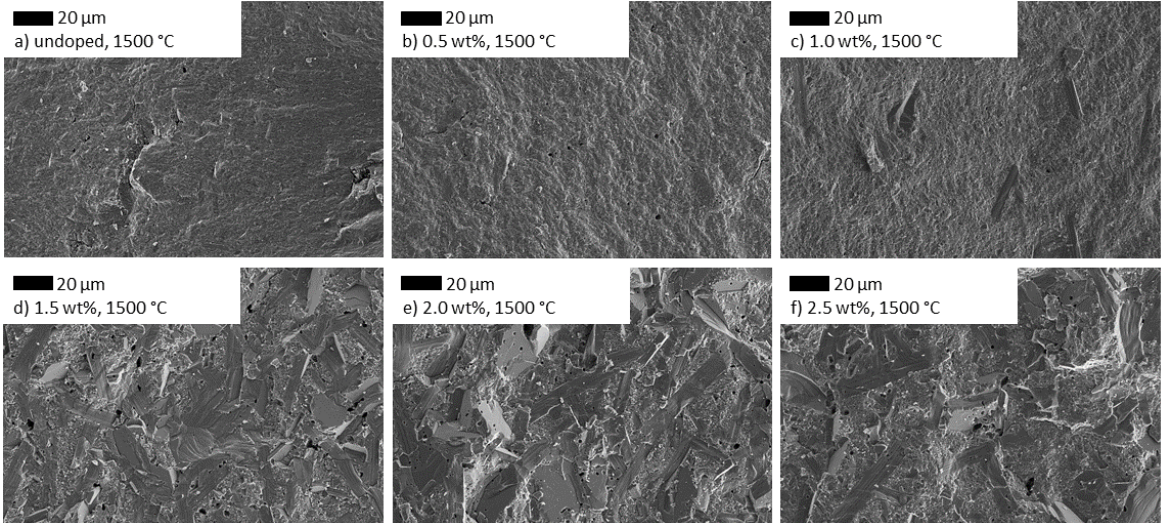
Figure 7. SEM images of Na- β″ -alumina samples sintered at 1500 °C, 1600 °C, or 1700 °C; ( a – c ) undoped samples; ( d – f ) Na- β″ -alumina doped with 1.5 wt% TiO 2 . Images ( a ), ( b ), ( d ), and ( e ) were rearranged and reprinted with permission from Dirksen et al. [13].